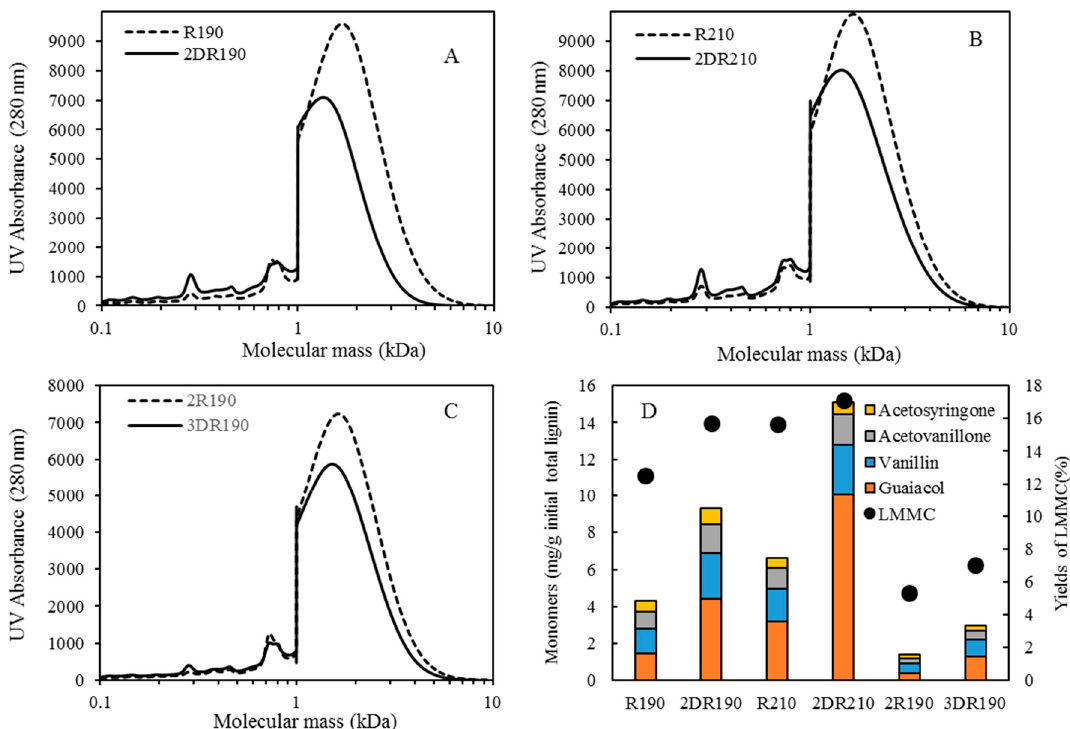
Figure 9. Molecular weight distributions, LMMC yields and monomer contents before and after the second round of 190–210 °C and the third round of 190 °C depolymerization (the process involving membrane separation). ( A ) SEC profiles of BLR before and after the second round of 190 °C depolymerization, measured as UV absorbance at 280 nm. ( B ) SEC profiles of BLR before and after the second round of 210 °C depolymerization. ( C ) SEC profiles of BLR before and after the third 190 °C depolymerization. ( D ) LMMC yields and the concentration of lignin monomers in LMMC from the second 190–210 °C and the third 190 °C depolymerized BLR samples.